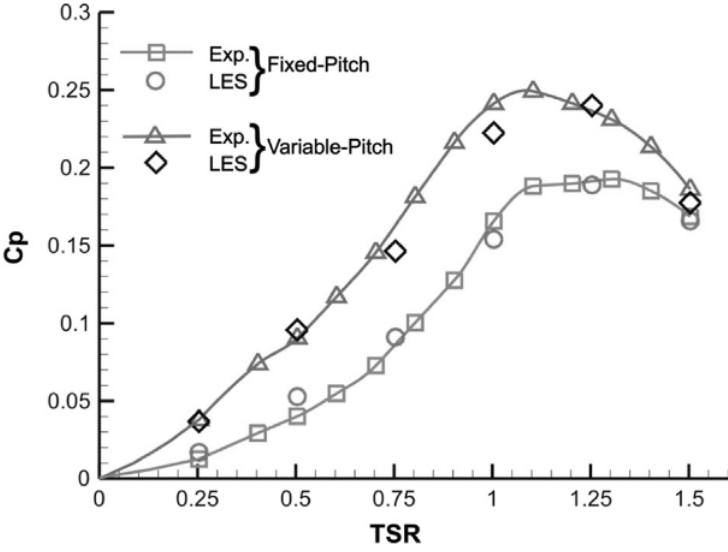
Figure 6. Comparison between experiment and CFD LES model prediction of the average power coefficient for an adjustable- and fixed-pitch angle, NACA0018 [31].